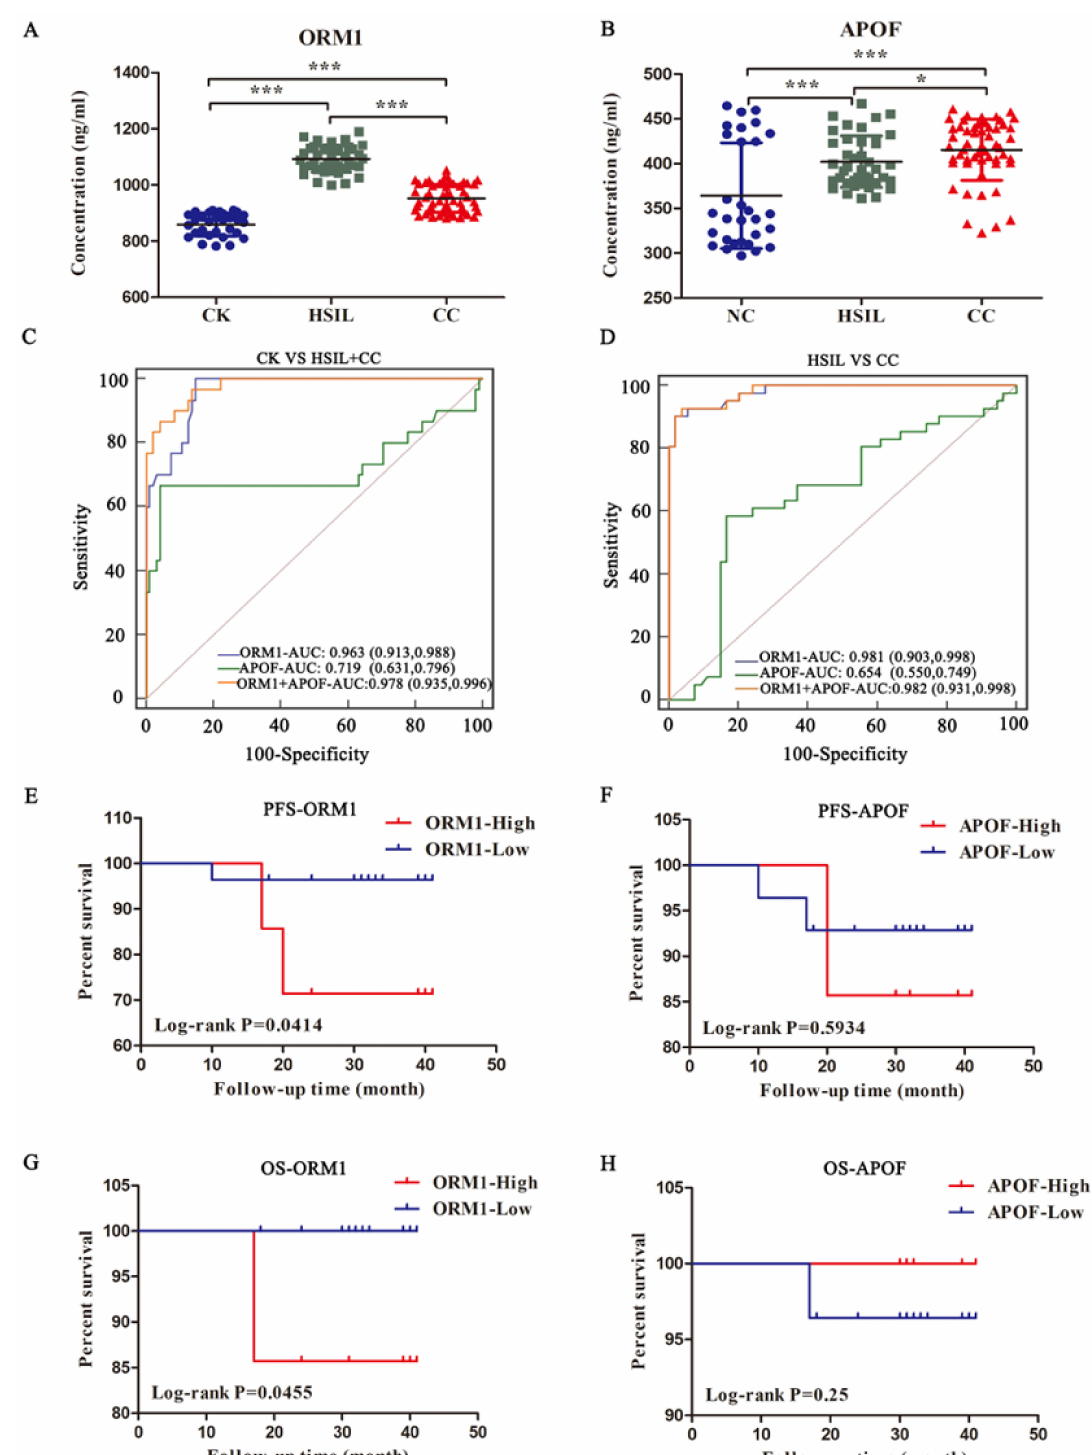
Figure 8. ELSIA verification of proteins identified by DIA analysis. The expression of hub proteins ORM1 ( A ) and APOF ( B ) was measured by ELISA. ( C ) The ROC of ORM1 and APOF in identifying CK and HSIL/CC; ( D ) The ROC of ORM1 and APOF in identifying HSIL and CC. ( E , F ) The PFS of ORM1/APOF high expression cervical cancer patients (20%) compared with the ORM1/APOF low expression (80%); ( G , H ) The OS of ORM1/APOF high expression cervical cancer patients (20%) compared with the ORM1 low expression (80%).* p < 0.05; *** p <